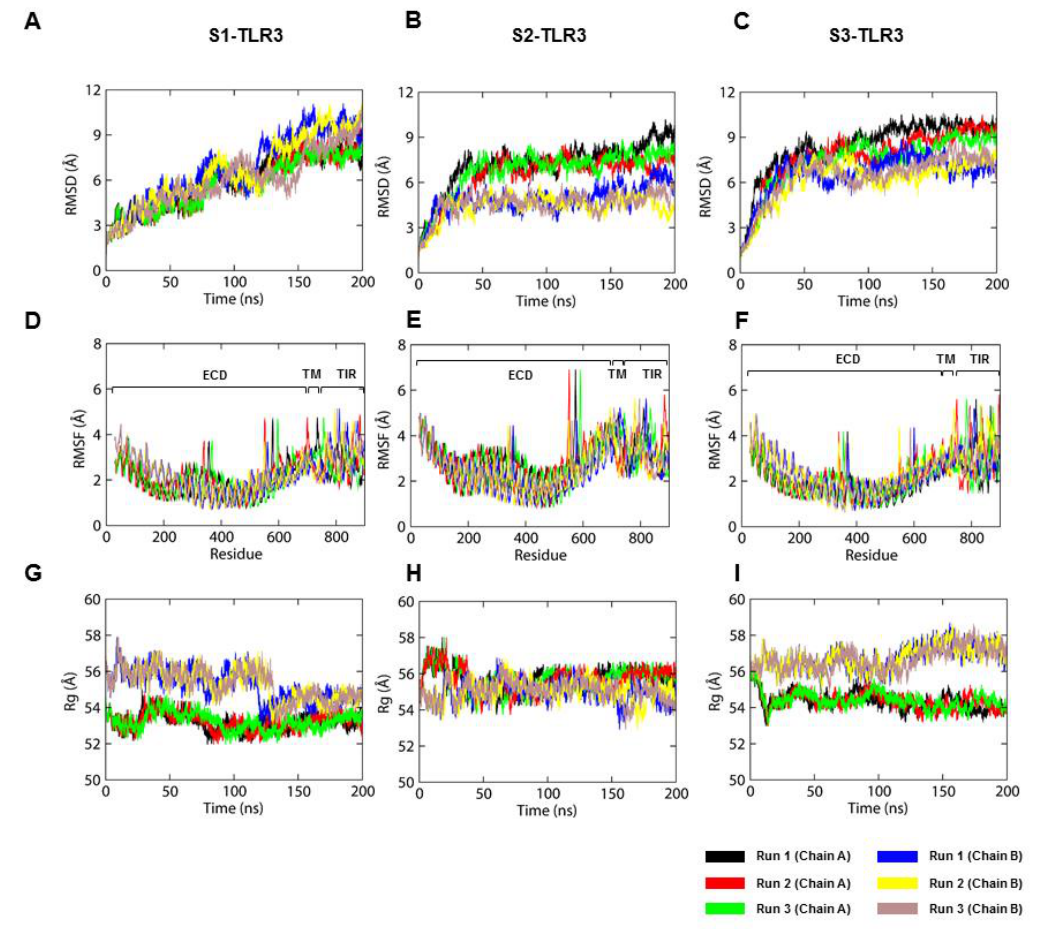
Figure 3. Stability parameters of the three TLR3 models over the course of the simulation. ( A – C ) Root mean square deviation. ( D – F ) Root mean square fluctuation. ( G – I ) Radius of gyration. The black and red lines represent subunits A and B, respectively. Table 1. The decomposition of the binding free energies (kJ mol − 1 ) of TLR3-dsRNA complexes. 1 ∆ 2 ∆ vdW